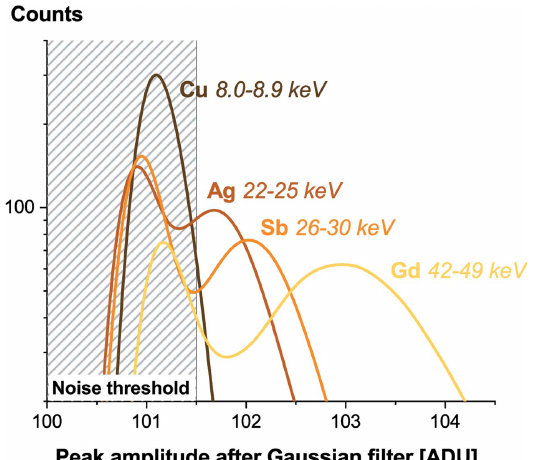
Figure 15 A histogram of detected peak amplitudes for various fluorescence targets. The scintillator is an 11 m m GOS:Tb screen and the pixel size is 6.5 m